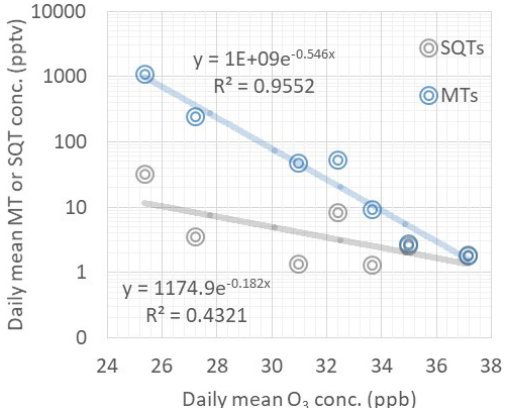
Figure 10. Dependence of daily mean ozone concentrations on daily mean monoterpene (MT) and sesquiterpene (SQT) concen- trations during the ambient air measurements in June and July in 2018.